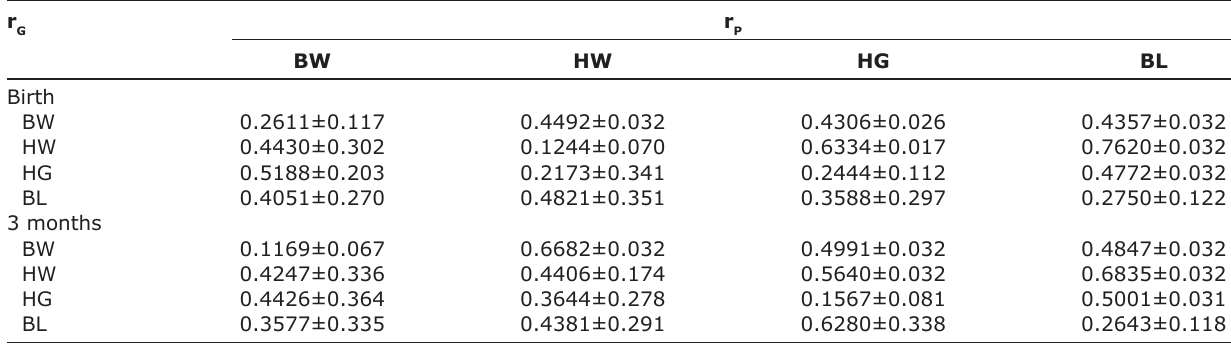
), and genetic (r ) correlation between body weight and body P G r